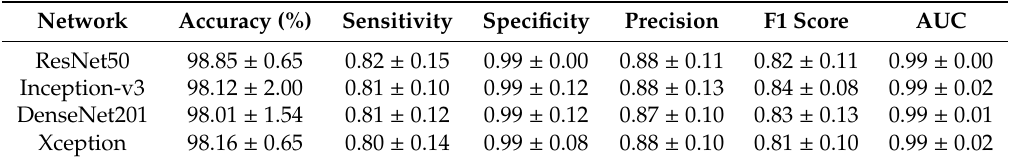
Table 6. 10-fold cross validation performance using our enhanced baseline method that included preprocessing.